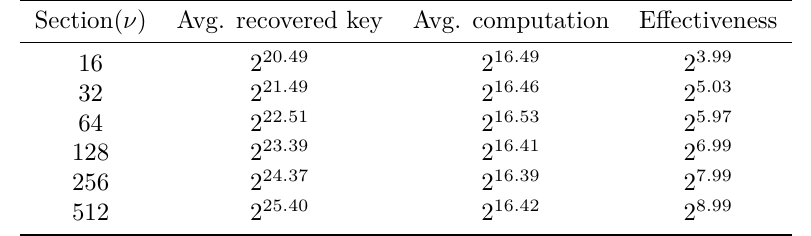
Table 4: Experimental verification of running Algorithm 2 with a single iteration ( κ = 32). Section( ν